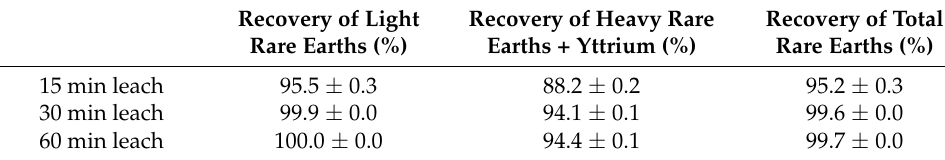
Table 4. Overall light and heavy rare earth dissolution (%): Perth monazite. Recovery of Light Rare Earths (%)